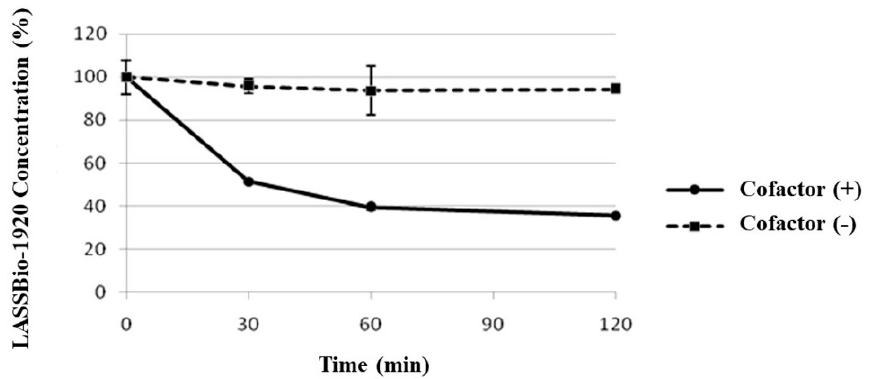
Figure 10. Metabolic stability of LASSBio-1920 using liver microsomal fraction of Wistar rats in the presence (+) or absence ( − ) of cofactor. Data are presented as a percentage of the compound concen- tration.